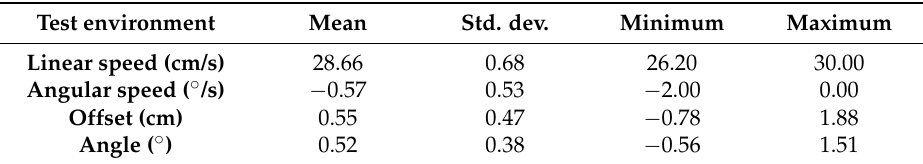
Figure 18. Crop row tracking behaviour. Images from ( a ) to ( d ) show a sequence of different frames of the video available in [65].